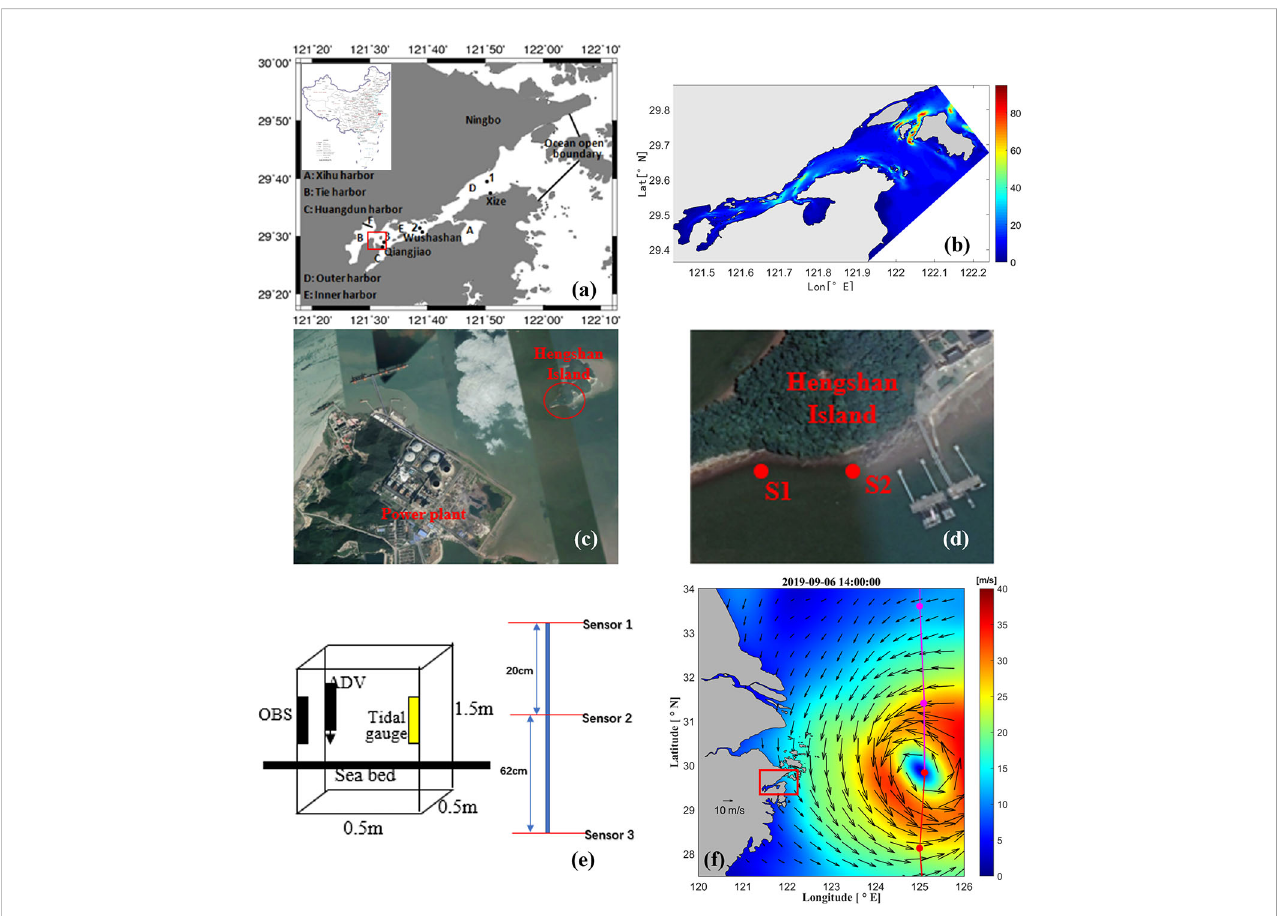
FIGURE 1 (A) Map of Xiangshan Bay (red box in Xiangshan Bay shows the positions of (C, D) . (B) Depth in the bay. (C) Locations of the power plants. (D) Field stations. (E) Arrangement of the instruments and the vertical distribution of temperature sensors below the surface of the tidal fl at. (F) The wind fi eld during Typhoon Lingling (13~55 m/s, 930~1002 hPa), and the path of the typhoon during fi eld work (red box shows the location of Xiangshan